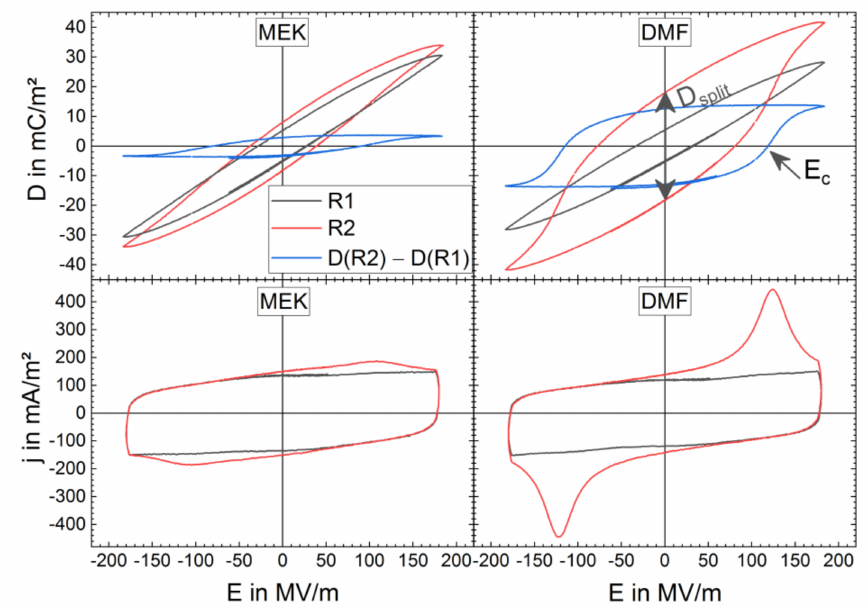
Figure 5. Bipolar electric displacement field D vs. electric field E ( top ) and corresponding current density j vs. electric field E ( bottom ) loops of BE cycling run 1 (R1) (black lines) and BE cycling run 2 (R2) (red lines) for films from MEK ( left ) and DMF ( right ) solutions with a cycling field amplitude maximum of E ampl = 183 MV/m. The difference of D-E loops of R2 and R1 (blue lines) are shown, and the D-E curve gap at zero field D split and position of coercive field E c are indicated for the DMF